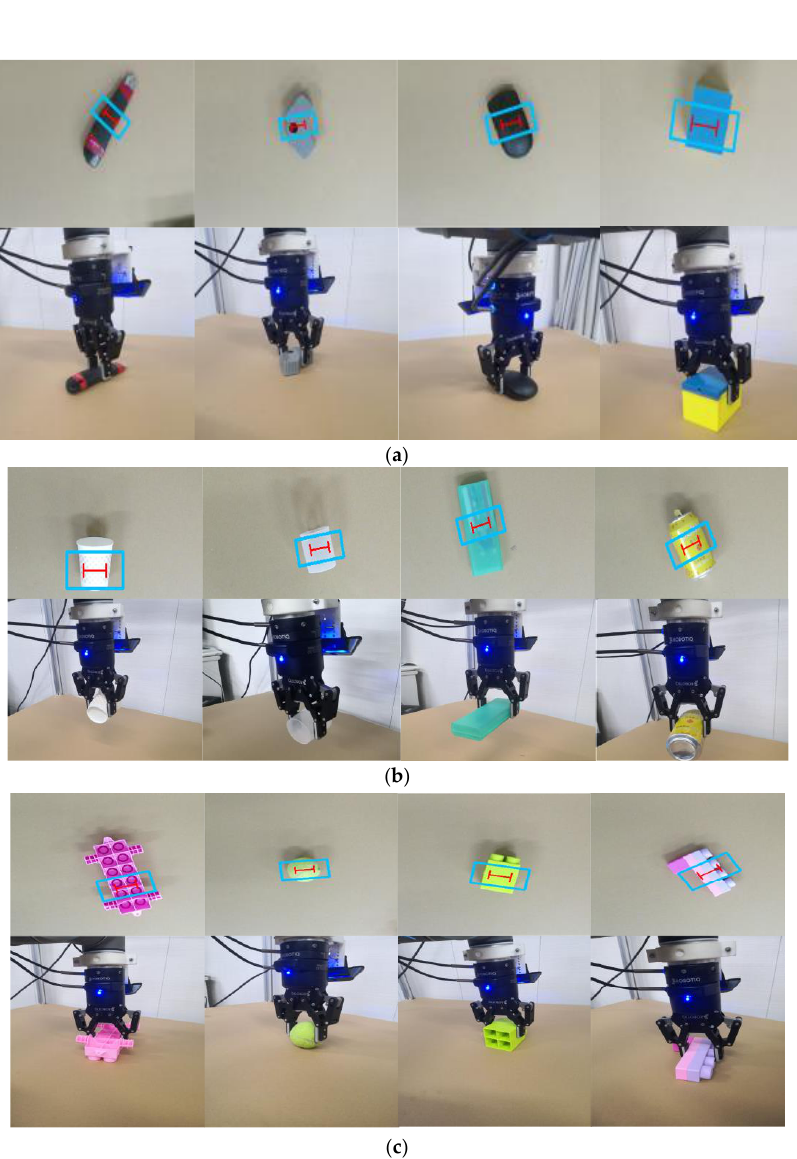
Figure 9. Robot grasping experiment on unknown objects: ( a ) detection and grasping on rigid objects, ( b ) robot grasping thin and easy deformed objects, ( c ) robot grasping flexible objects. The blue rectangle refers to the opening width when the gripper approaches the object, and the red “I” represents the closing width when the gripper picks up the object.